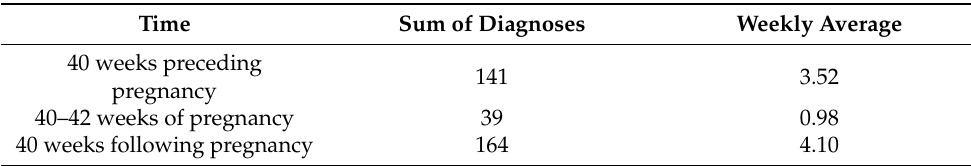
Table 2. Number and weekly mean of the first MS diagnosis in the 40 weeks before, during and after pregnancy.